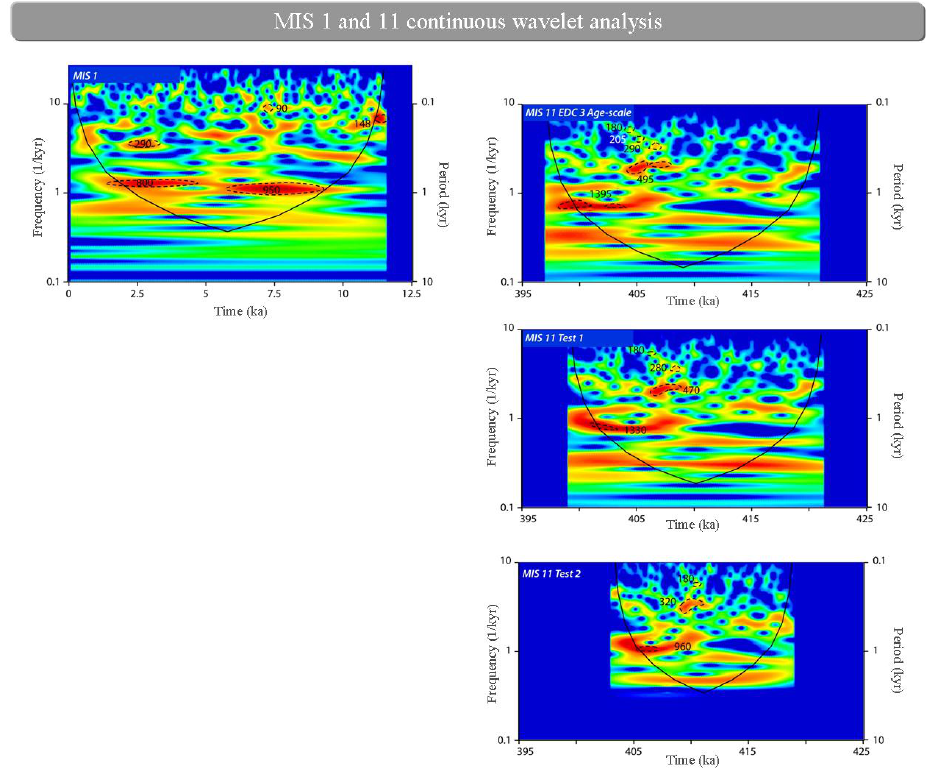
Fig. 3. Spectral analysis of the detrended signals (displayed on Fig. 2, panels b) for MIS 1 (left) and MIS 11 (right), using EDC3 chronology (top), Test 1 age-scale (middle) and Test 2 (bottom). The spectral power is displayed in function of time (ka) in term of frequency (1/kyr, left axis) or period (kyr, right axis). Black lines correspond to the cone of influence; dotted lines indicate the significant periodicities (application of the statistical test of Torrence and Compo: